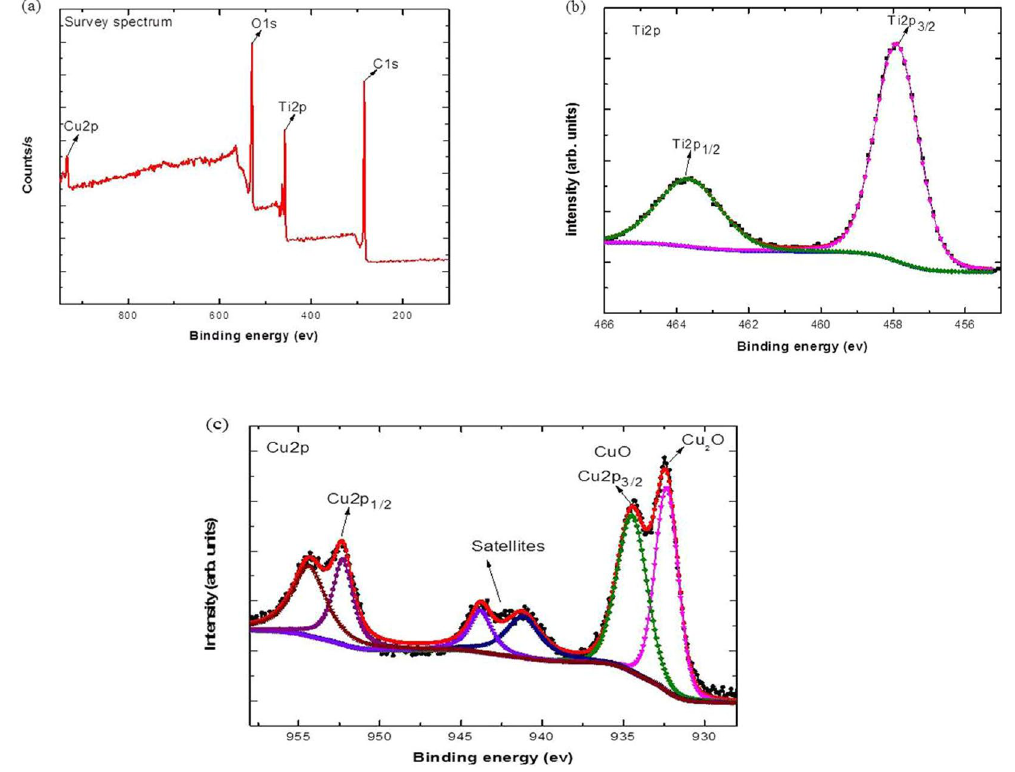
Figure 7. XPS spectrum ( a ) Full survey spectrum ( b ) High resolution fitted spectrum of Ti2p ( c ) High resolution fitted spectrum of